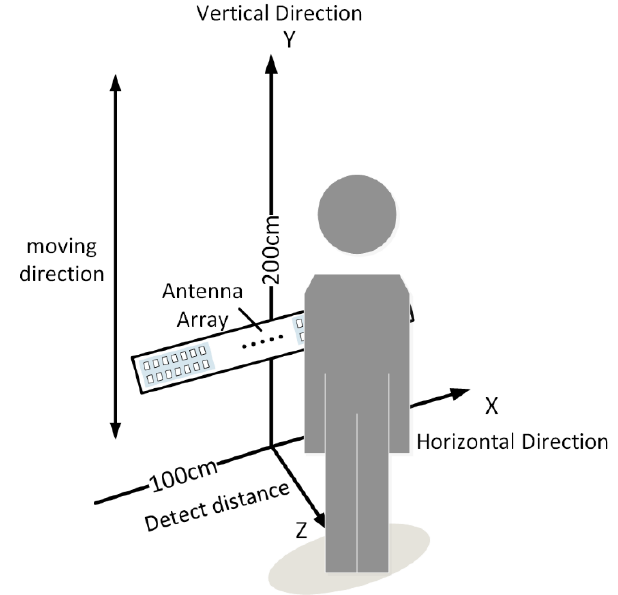
Figure 1. System structure diagram.